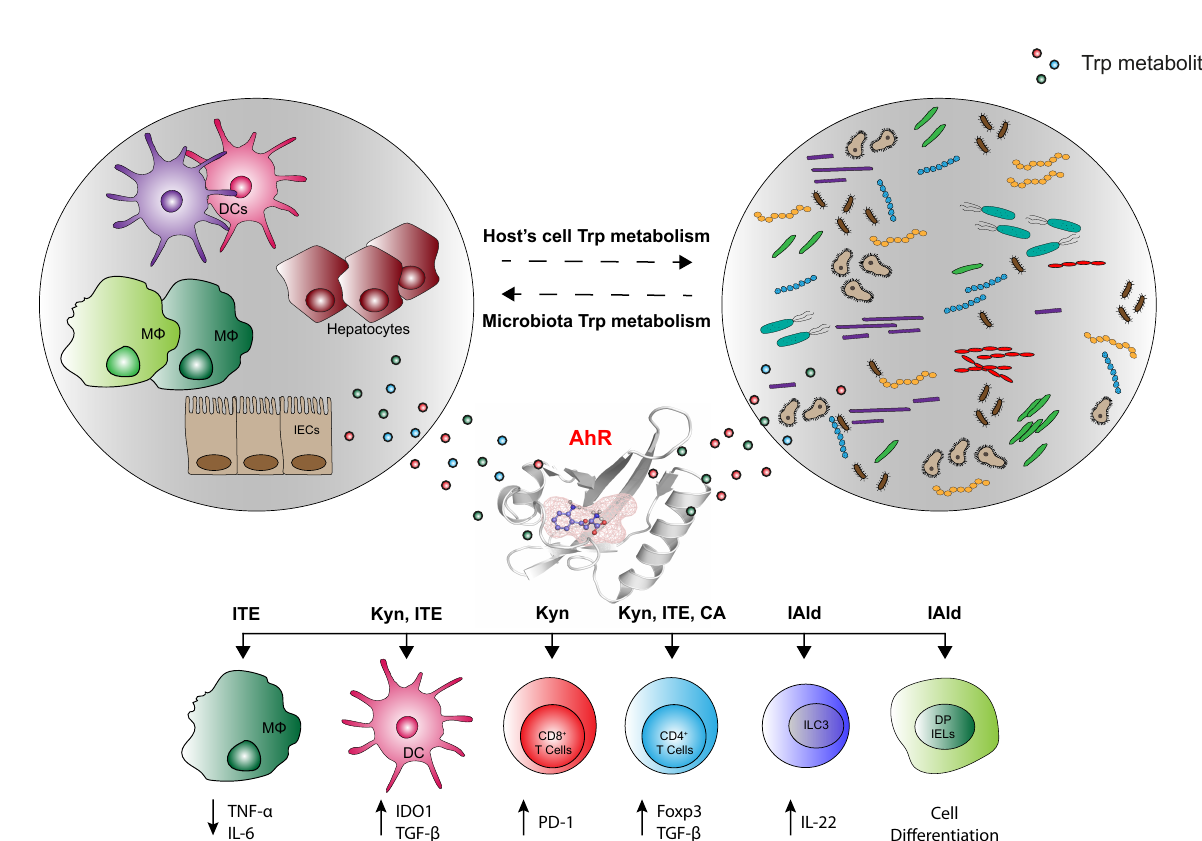
Figure 3. Tryptophan metabolites derived from host’s immune cells and microbiota can influence immune cell functions. Tryptophan metabolites derived from commensal bacteria and host’ cells have a critical role in modulating the homeostasis and function of innate and adaptive immune cells through indirect and direct mechanisms [71,72]. Tryptophan metabolite can activate signal transduction pathways and transcriptional programs that control the differentiation, proliferation, maturation and effector functions of many cells through activation of AhR. AhR is expressed in immune and non-immune cell types, such as intestinal epithelial cells (IECs) [73], macrophages (M Φ ) [74], dendritic cells (DCs) [75], T cells [76], double- positive intraepithelial lymphocytes (DP IELs) [77], and innate lymphoid cells (ILCs) [32]. Molecules produced by host’s immune cells and microbiota can activate AhR and influence their cytokines production, cell differentiation and function (ITE: 2-(1 (cid:48) H-indole-3 (cid:48) -carbonyl)-thiazole-4-carboxylic acid methyl ester; Kynurenine (Kyn); Cinnabarinic acid (CA); Indole-3-aldehyde